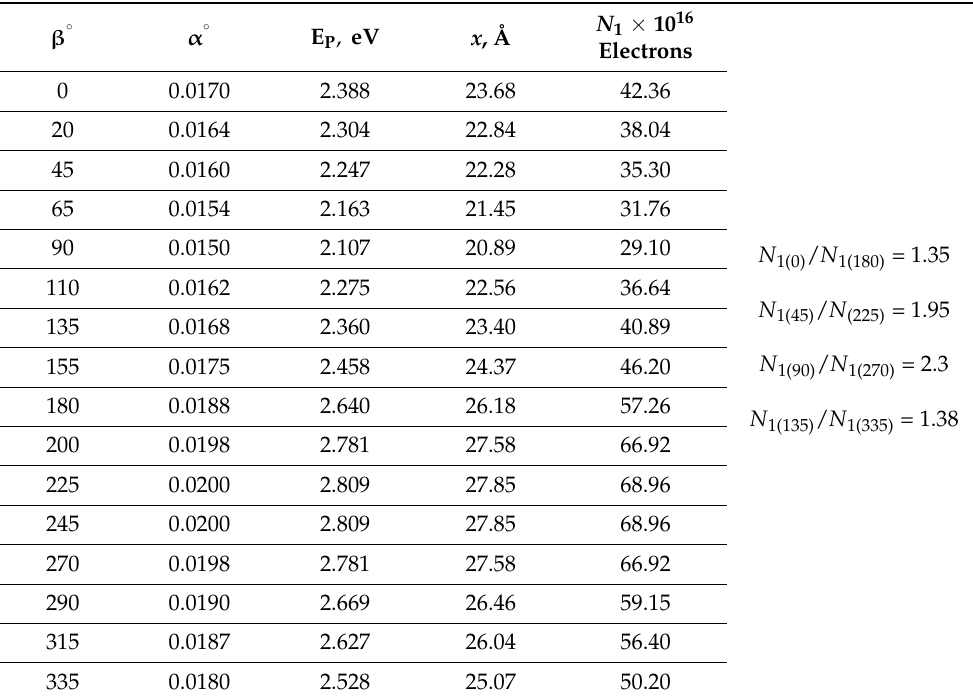
β azimuth angle; α experimental angle of sliding incidence of X-rays; E P energy of surface plasmon; x the depth of TER of X-rays output with surface; p—plasmons excitation; N 1 the number localized electrons involved in formation of TER of X-rays and excitation of surface plasmons; in electronic asymmetries, azimutal angles β in brackets are